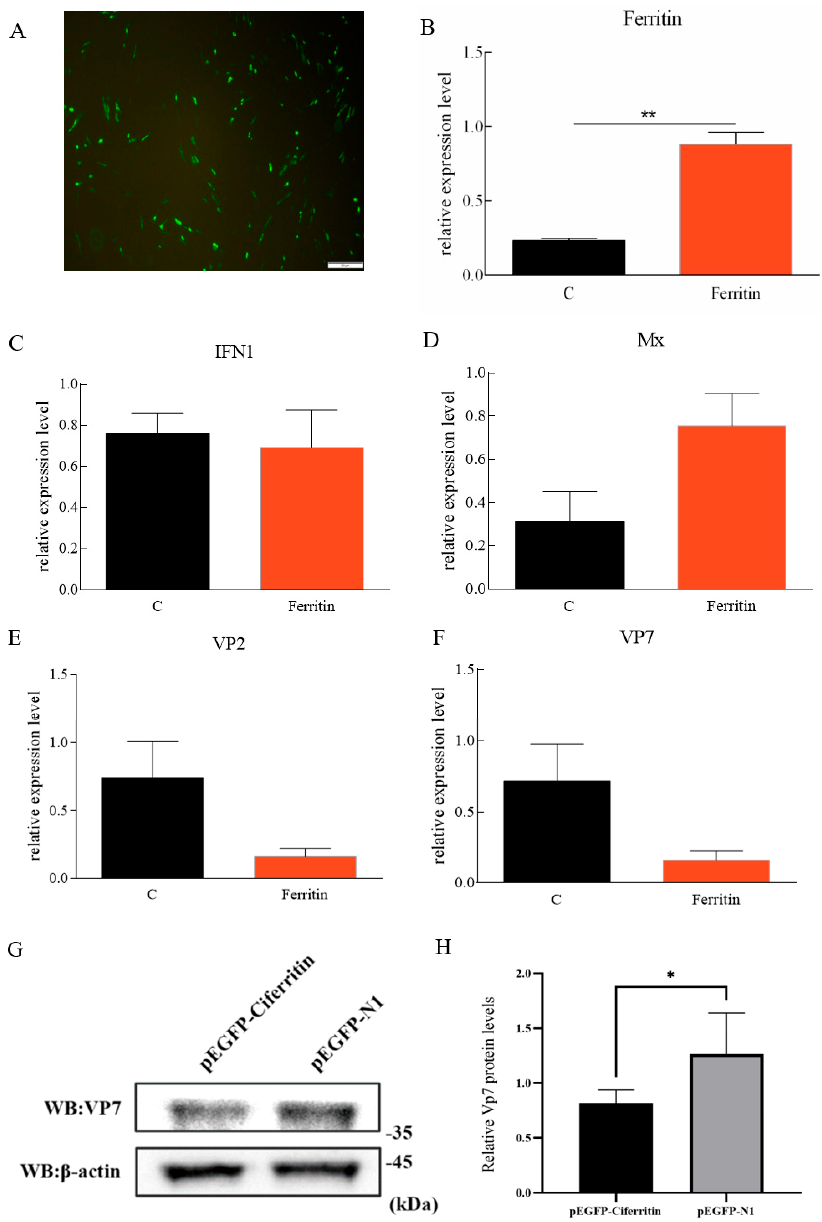
Figure 8. Effects of Ciferritin overexpression on immune reaction and GCRV replication. ( A ) Cell fluorescence of Ciferritin overexpression; ( B ) Ciferritin mRNA level; ( C ) CiIFN1 mRNA level; ( D ) CiMx mRNA level; ( E ) VP2 expression level; ( F ) VP7 expression level; and ( G , H ) VP7 protein level. An asterisk (* ) denotes a significant differences ( p < 0.05) , and ** indicates p < 0.01.